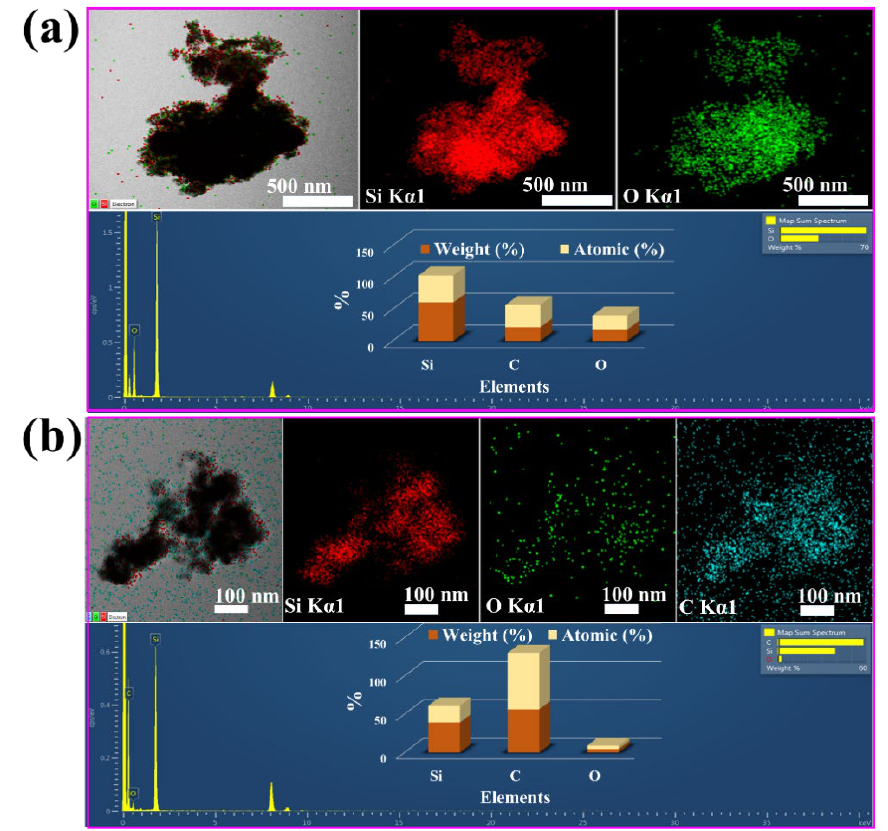
Figure 7. HR-TEM/EDS mapping, corresponding spectrum, and the atomic/weight percentages of ( a ) B-Si and ( b ) M-Si, respectively.